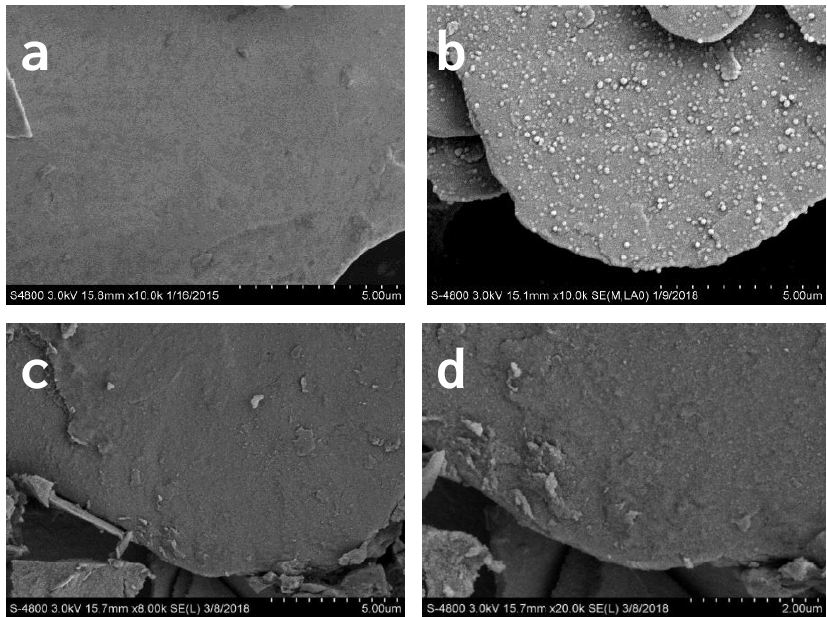
Figure 8. SEM images of raw aluminum pigments ( a ); Al@SiO 2 ( b ); and Al@SiO 2 @PFMV ( c , d ).